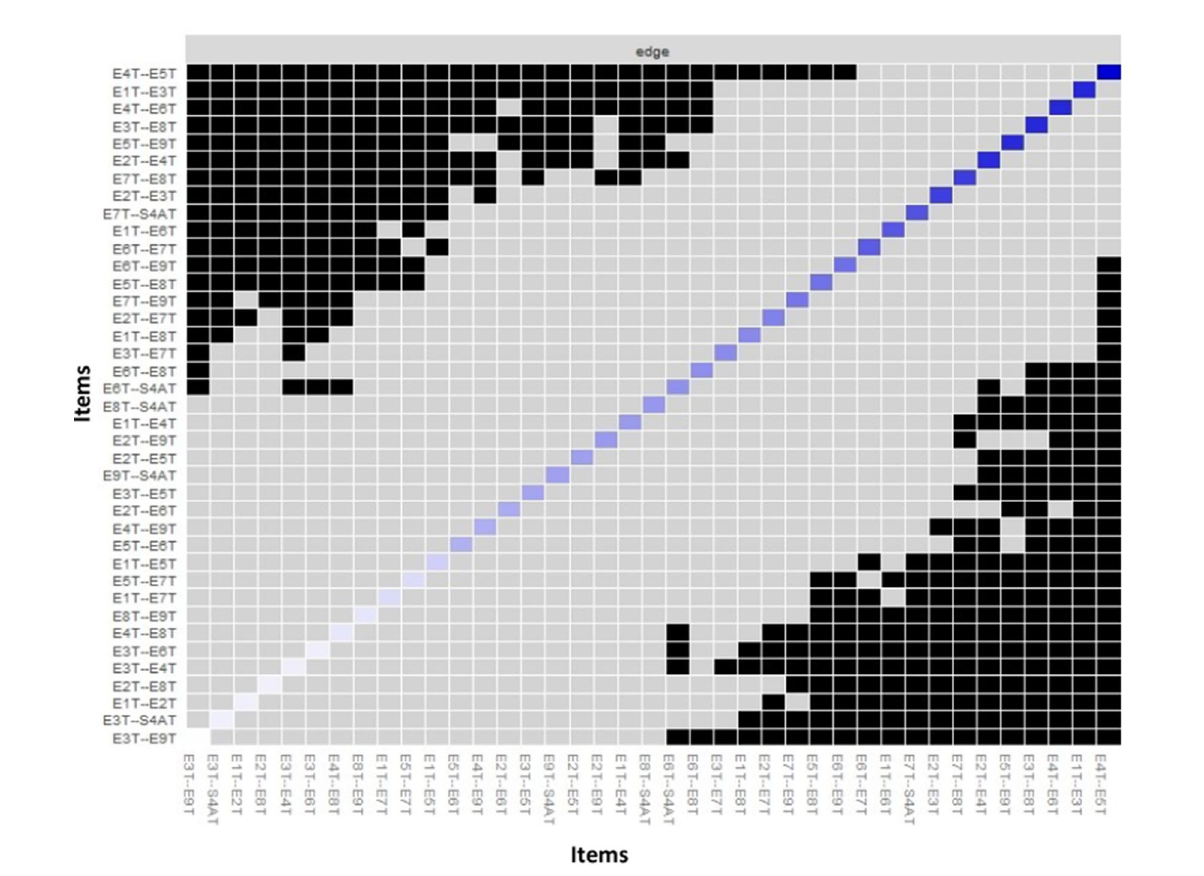
FIGURE 7 Bootstrap difference test for edge weights. T1: type 1; T2: type 2; T3: type 3; T4: type 4; T5: type 5; T6: type 6; T7: type 7; T8: type 8; T9: type 9; S4AT: healthy personality to psychosocial